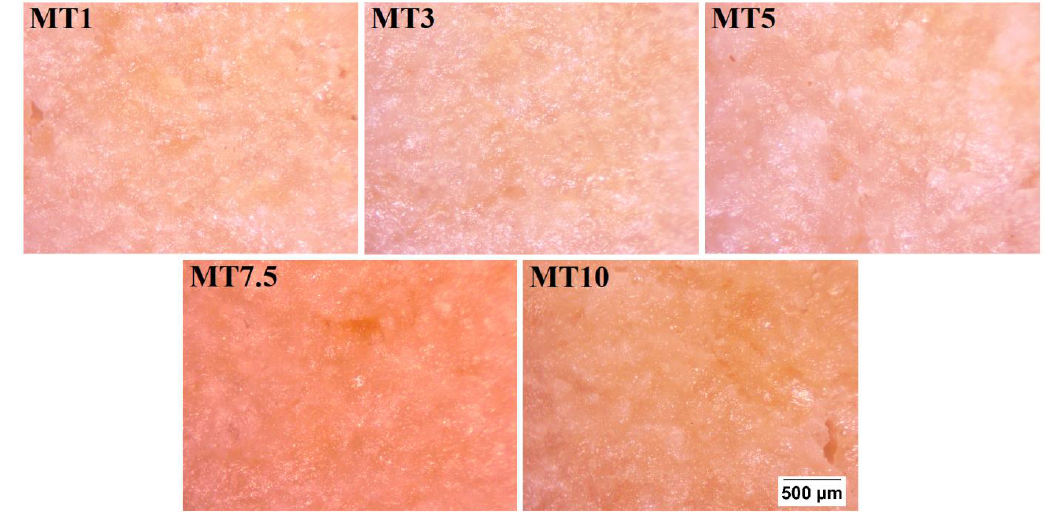
Figure 13. Surface topographs of